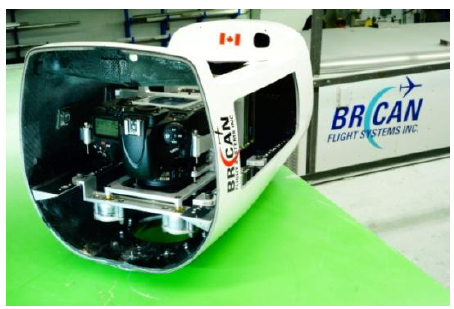
Figure 17: AP20 TD100 installation